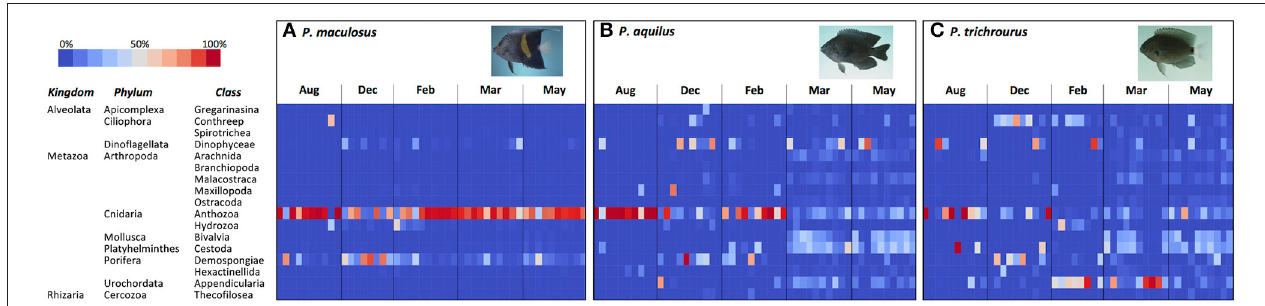
FIGURE 3 | Heatmap illustrating stomach content composition in three species of reef fish ( A , P. maculosus ; B , P. aquilus ; C , P. trichrourus ) collected over five sampling periods in Abu Dhabi, UAE. Each cell in the heatmap represents the relative abundance (percent of reads from stomach contents; see key) of a class of organisms in a sample’s stomach at a particular sampling period (month). Fish images from http://www.fishbase.org (Randall, unpublished).